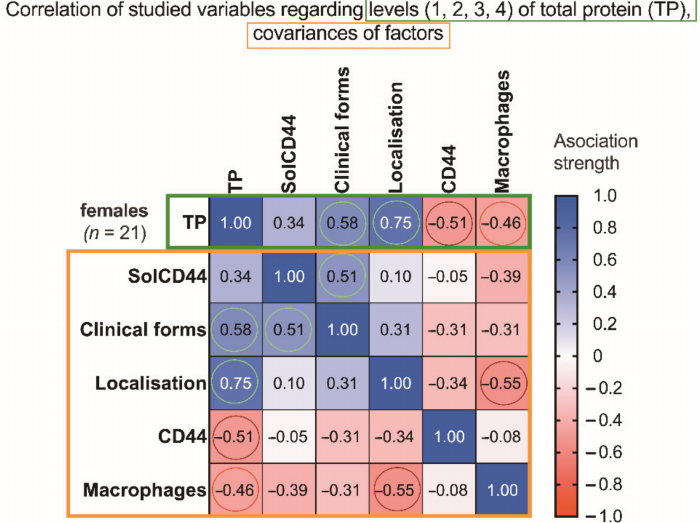
Figure 2. Association strength of studied variables: SolCD44, clinical form of leukoplakia, localiza- tion of oral leukoplakia, mean number of CD44 expressed in epithelial layers in leukoplakia tissue, mononuclear cells (macrophages under the basal membrane), and gender of patients with leukoplakia ( n = 21) regarding levels of total protein (and covariances) in the female group. Spearman’s rank cor- relation matrix: numbers in squared cells show value of correlation coefficient, indicating association strength; colored circles denote most significant associations (red, negative; green, positive).